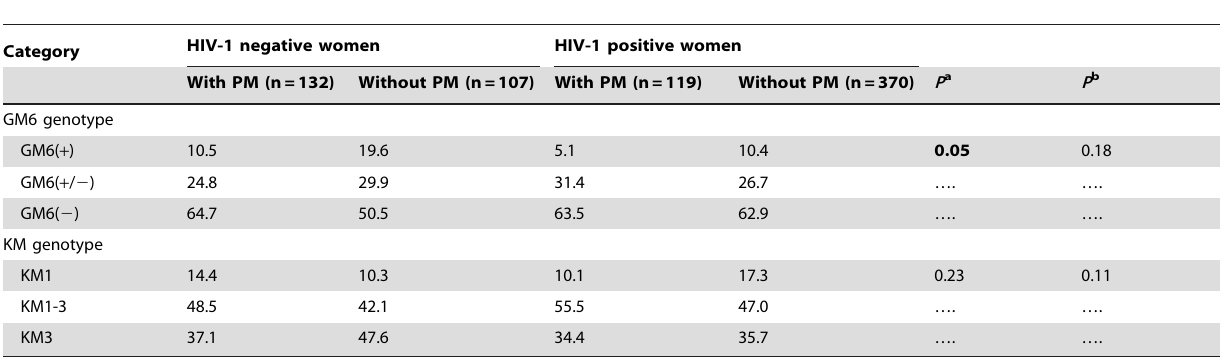
Table 2. Distribution of individual GM6 and KM genotypes in HIV-1 negative and HIV-1 positive women, by PM status.